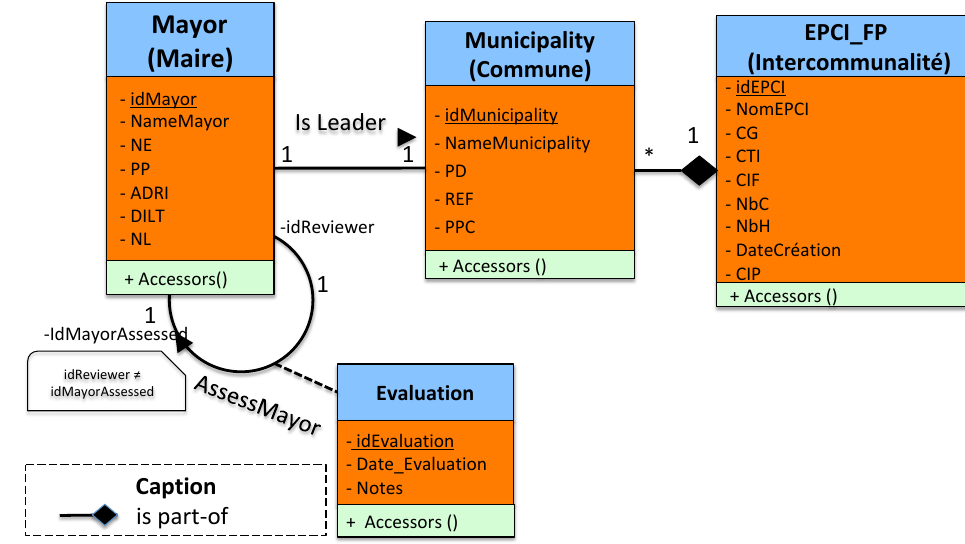
Figure 28. UML class diagram of